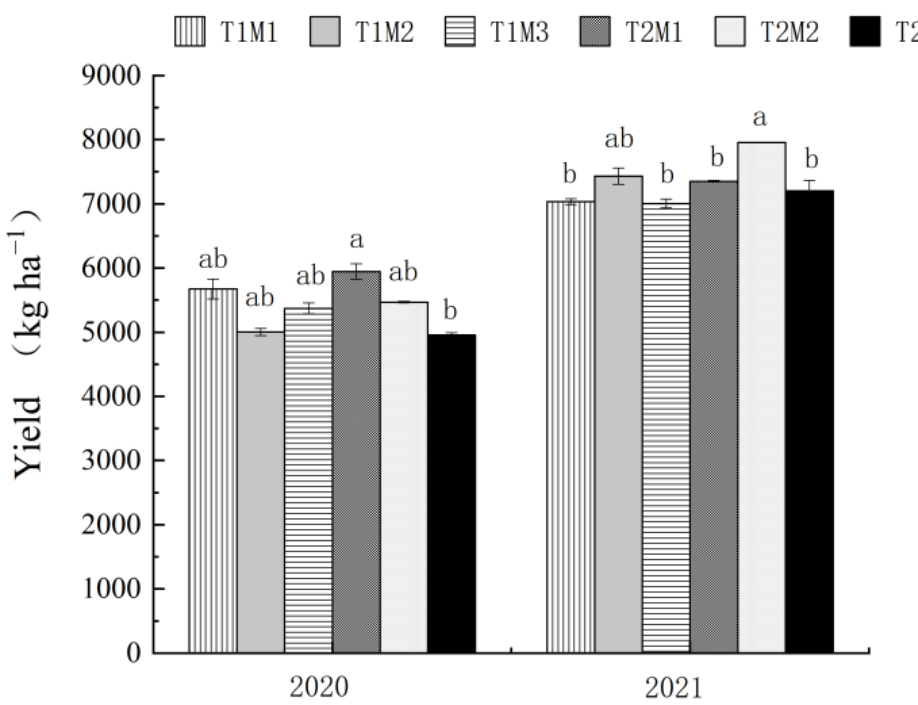
Figure 1. Response of rice grain yield to different nitrogen fertilizer application rates and planting densities. Note: F, variance statistic; N, nitrogen; PD, plant density. The means of treatments were compared based on the least significant difference (LSD) test at a probability level of 0.05. Different lowercase letters indicate a significant difference. * indicates a significant level of 0.05 ( p < 0.05), ns — non-significant.